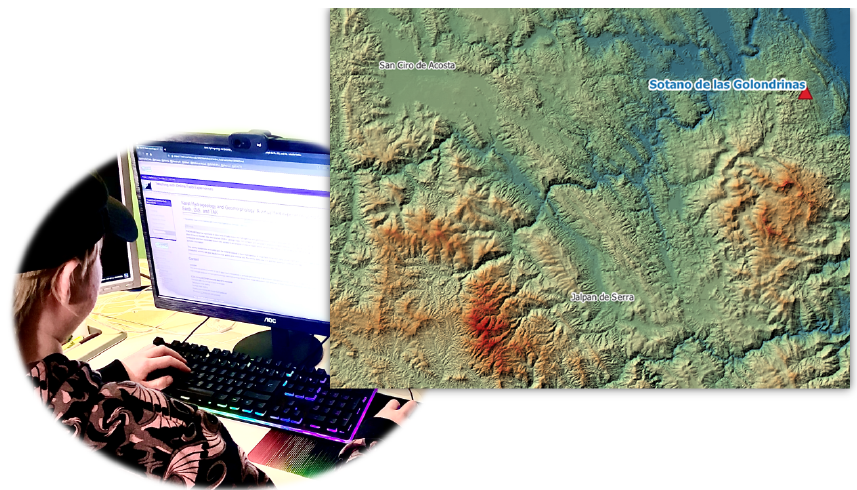
Figure 3. Reprojected, hillshaded, and a colored-by-elevation digital elevation model of the Sótano de las Golondrinas area, Mexico, in QGIS. Photo by the